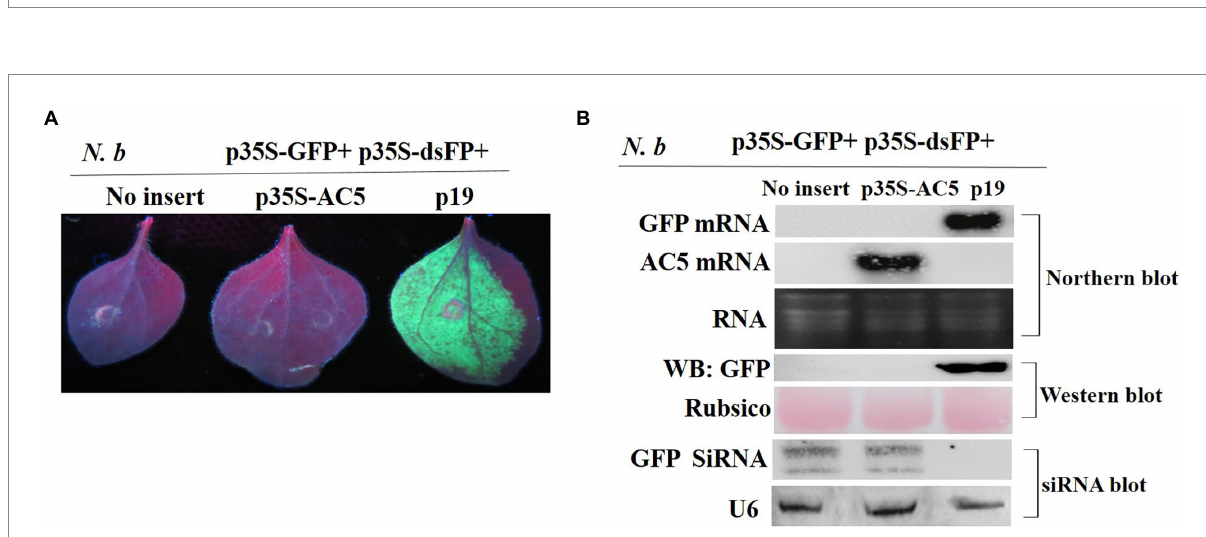
FIGURE 4 The SLCCNV AC5 could not inhibit GFP silencing of double-stranded dsRNA. (A) Representative 16c leaves were co-infiltrated with A . tumefaciens cultures harboring the p35S-GFP, double-stranded GFP (p35S-dsFP) and vector pGreenII 62-SK, p35S-AC5-expressing vectors or p19. Images were photographed under UV light at 4 dpi. (B) Northern blot of GFP and AC5 mRNA accumulation, western blot of GFP protein accumulation, and siRNA blot of GFP siRNA accumulation in Agrobacterium -infiltrated leaf patches. Ethidium bromide staining of rRNA and Ponceau S staining of the subunit of Rubisco served as loading controls. U6 was the loading control in the siRNA